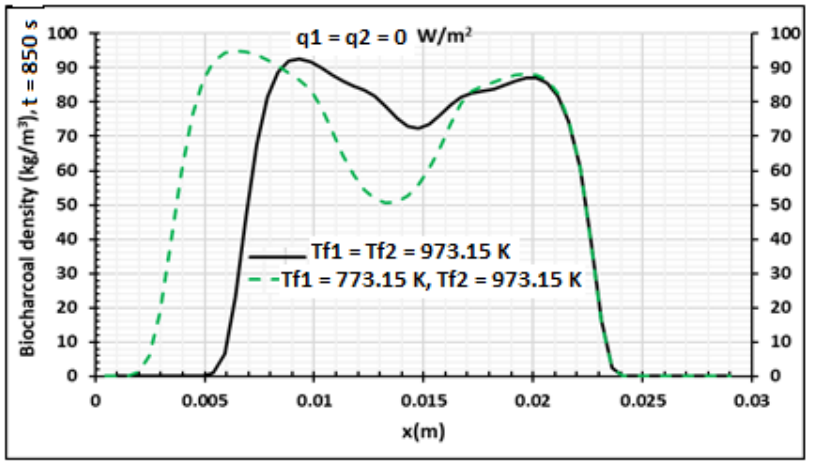
Figure 14. Density distribution. Production of the biocharcoal at q 1 = q 2 = 0 W/m 2 using samples of 30 mm thickness, ρ bo = 700 kg/m 3 . Influence of the contact temperature, t = 850